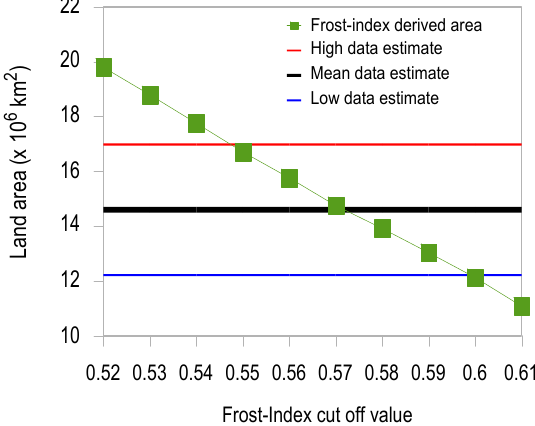
Figure 8. Total land area with a frost index higher (colder) than the x axis cut-off value, for frost-index data from Zhang (1998) (NSIDC). Horizontal lines show the Zhang et al. (2000) data es- timates for area of land underlain by